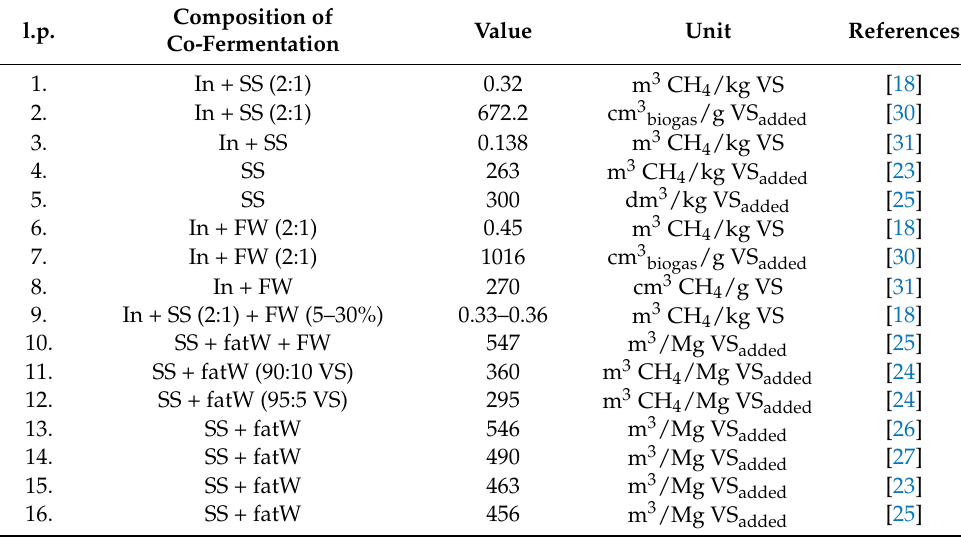
Table 4. The literature review of biogas and methane production for various feedstock in the co- fermentation